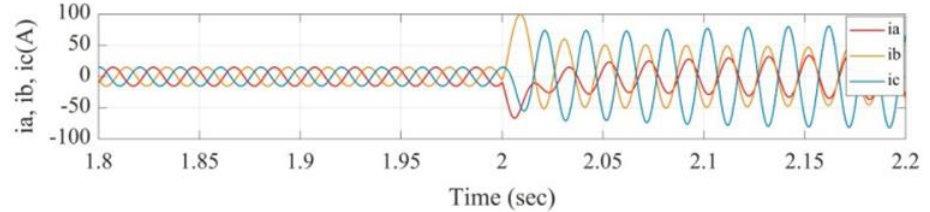
Figure 10. Current signals for phase a to phase b fault.